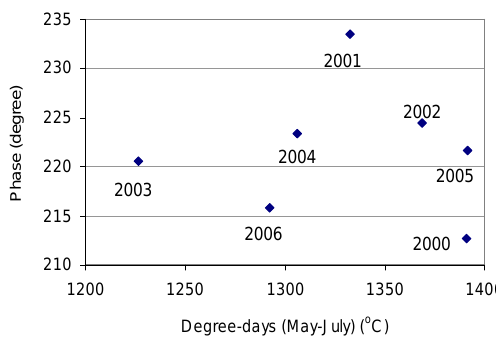
Fig. 10. (a) Area-averaged phase value of 12-month Fourier harmonic component of year N versus total river streamflow of year (N-1); (b) Area-averaged phase value of 12-month component of year N versus total river streamflow of April through May of year N. The river streamflow was measured at Fig. 11. Area-averaged phase value of 12-month Fourier harmonic component versus degree-days for Fig. 11. Area-averaged phase value of 12-month Fourier harmonic the Zhengyixia gauge station. component versus degree-days for May through July between 2000 May through July between 2000 and 2006. and